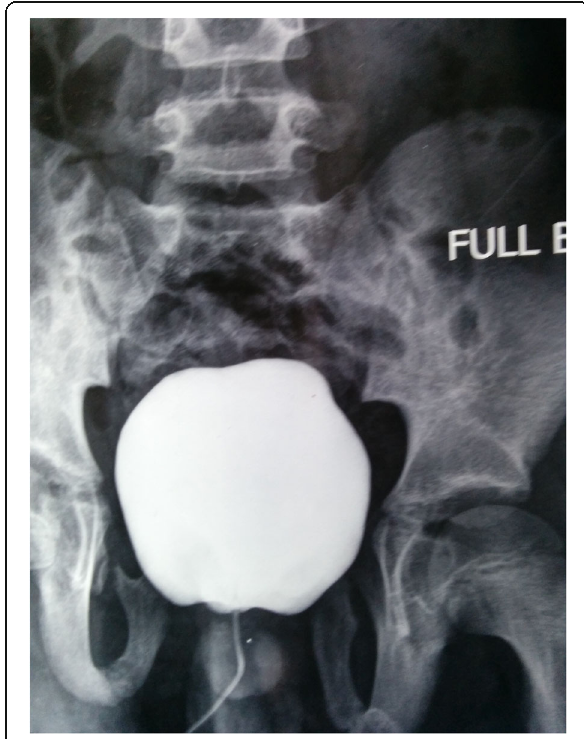
Fig. 5 MCU showing bladder growth post-operatively in an exstrophy patient with a closed bladder